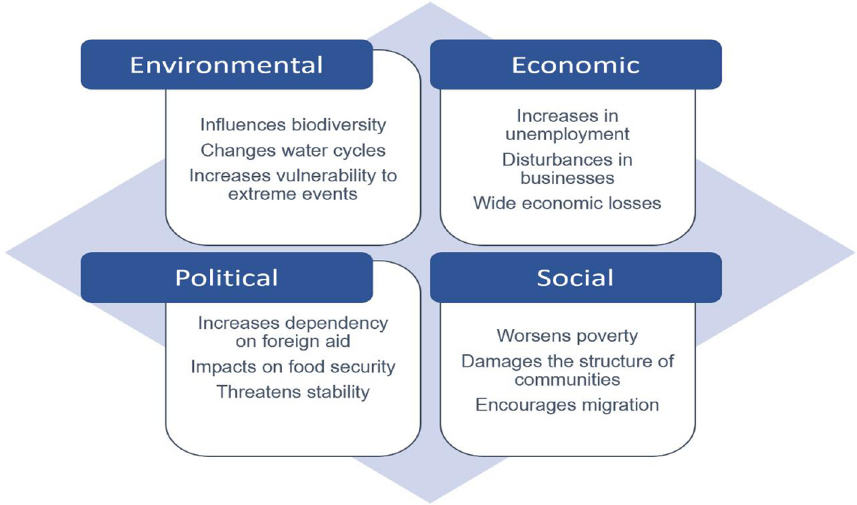
Figure 1. Some of the